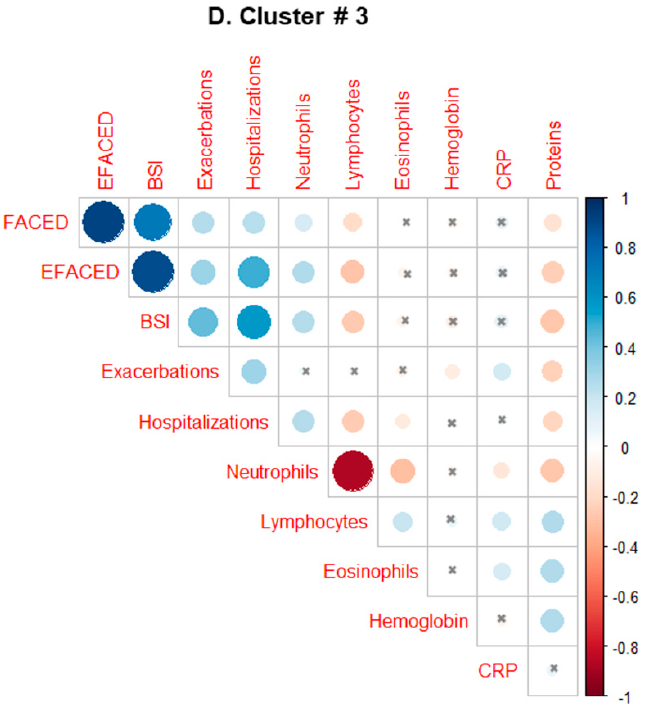
Figure 7. Correlation matrix of the disease severity and analytical variables, in which the positive correlations are represented in blue, while the negative correlations are represented in red: ( A ) all the study patients, ( B ) patients in cluster # 1, ( C ) patients in cluster # 2, and ( D ) patients in cluster # 3. The intersection within the circle represents a p -value > 0.05. The color intensity and the size of the circle are proportional to the correlation coefficients, as indicated in the Y-axis on the right-hand side of the graph.